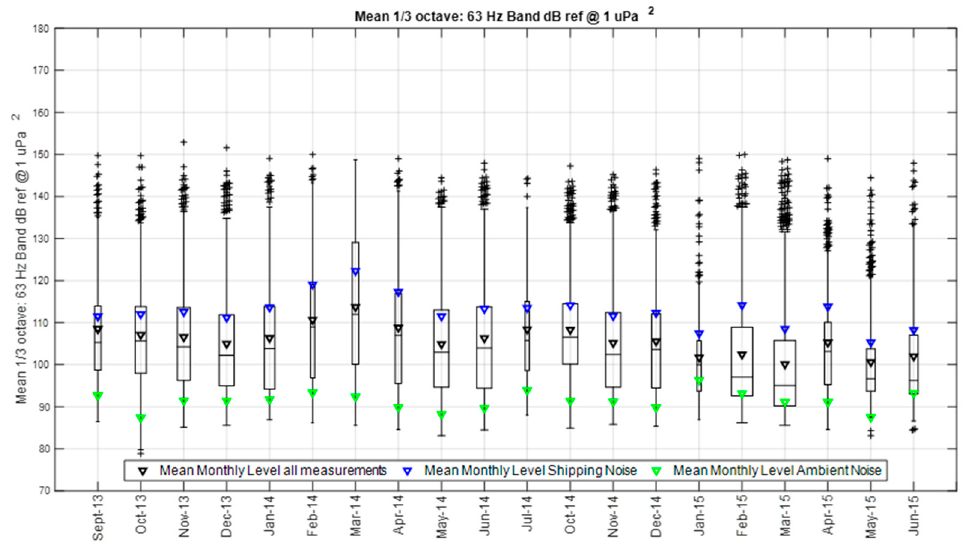
Figure 7. Monthly average evolution of the maximum of the 1/3 octave band at 63 Hz of all measurements. The mean monthly values of shipping, other anthropogenic, and natural noise measurements are represented with blue, black, and green triangles, respectively.